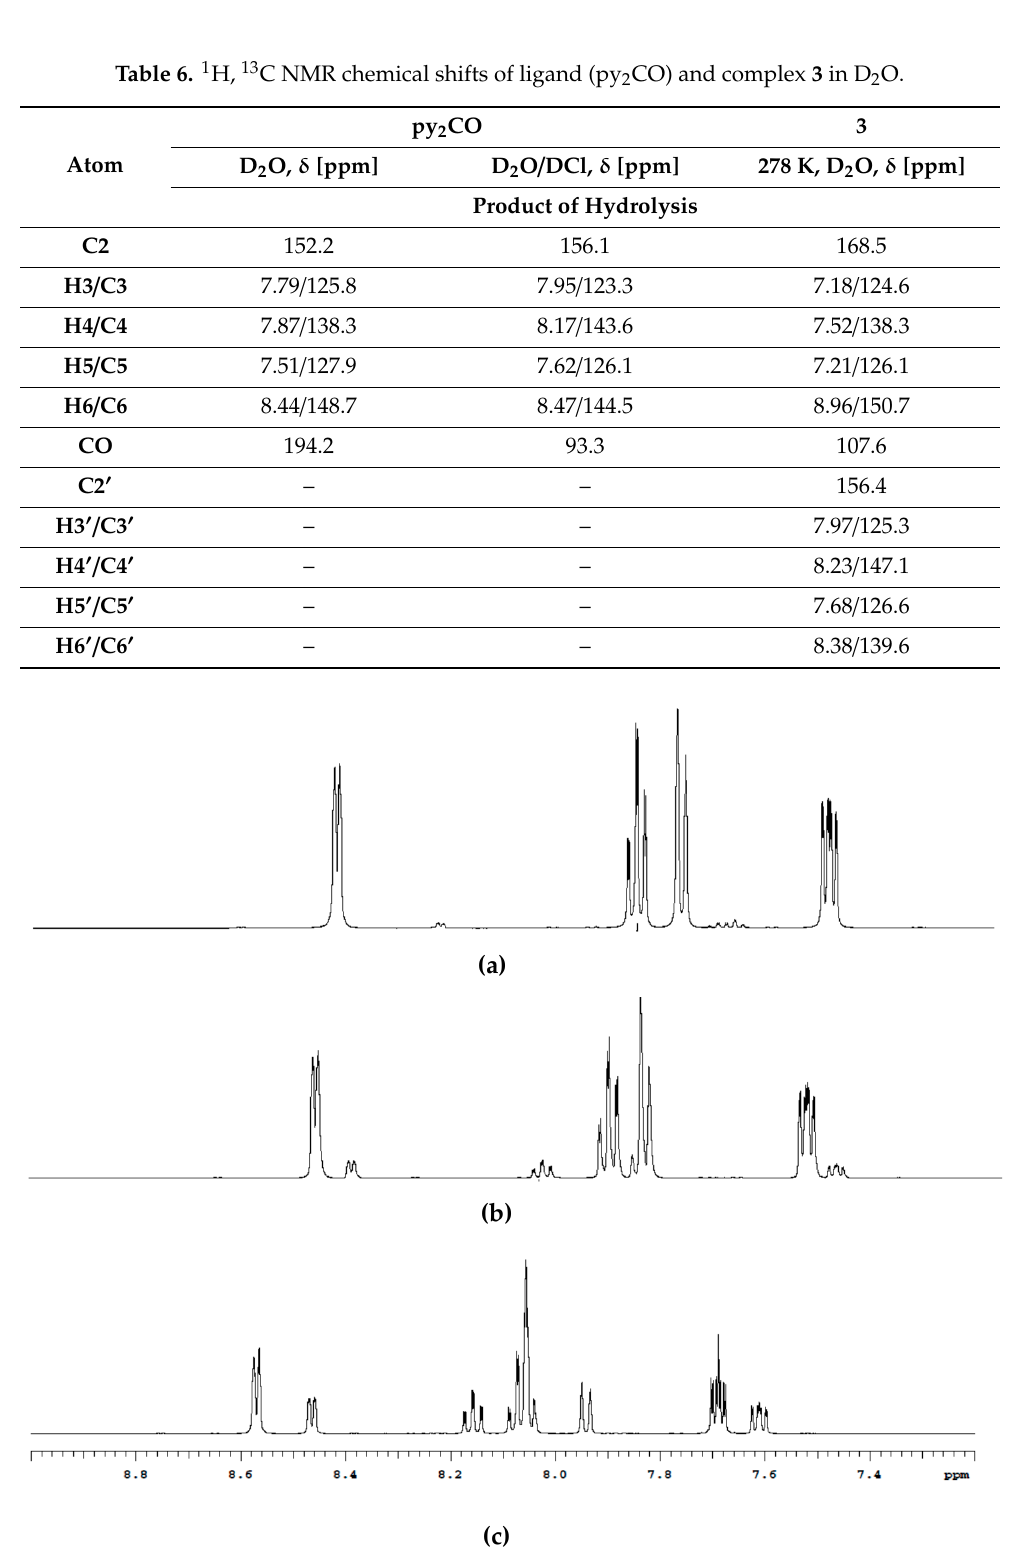
Figure 7. 500 MHz 1 H NMR spectra of a solution ( a ) containing 15 mg of py 2 CO dissolved in 0.5 mL of D 2 O (99.8%), ( b ) solution (a) + 10 µL of 5% DCl/D 2 O, ( c ) solution ( b ) + 25 µL of 5% DCl/D 2 O, showing changes in the equilibrium of the keto carbonyl group (py 2 CO) to gem-diol (py 2 CO · H 2